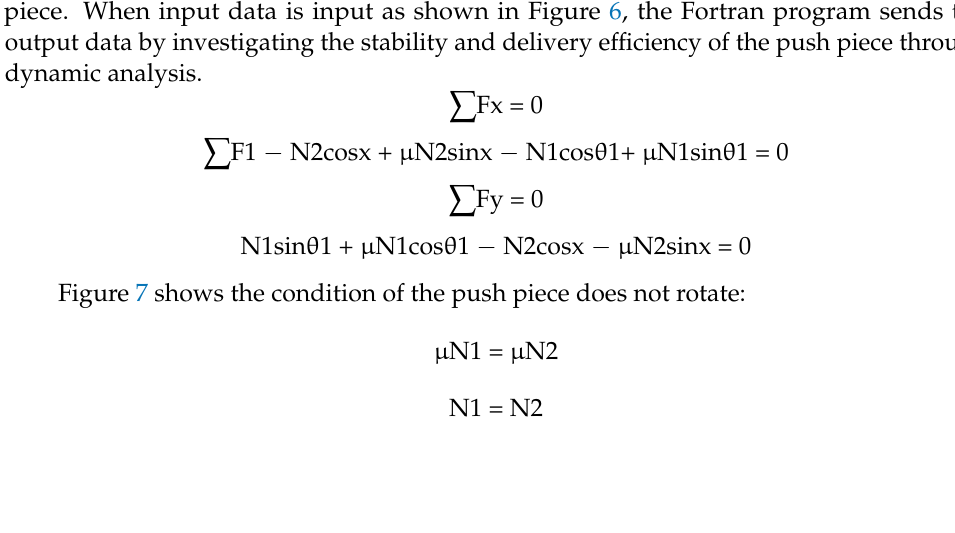
Figure 5. Slide plate and guide plate design with a spline curve.